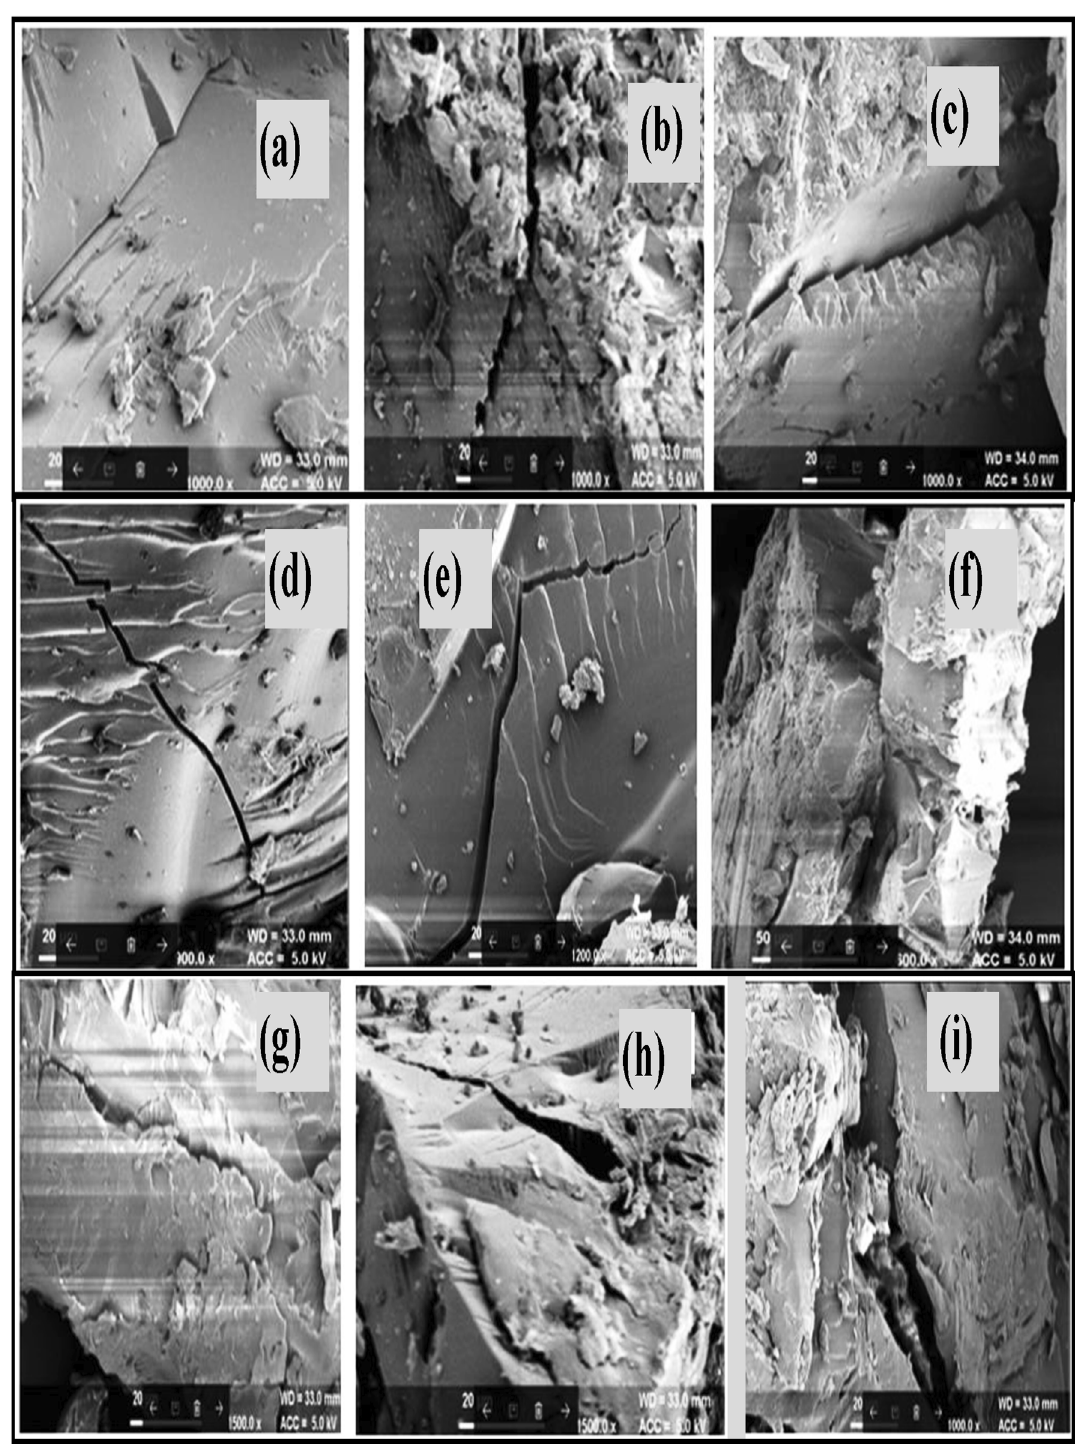
Fig. 8 a–i SEMs of biodegradation of a Av-cl-poly(AA) stage-I; b Av-cl-poly(AA) stage-II and c Av-cl-poly(AA) stage-III using soil burial method; d Av-cl-poly(AA) stage-I; e Av-cl-poly(AA) stage–II and f Av-cl-poly(AA) stage-III using composting method; g Av-cl-poly(AA) stage-I; h Av-cl-poly(AA) stage–II; and i Av-cl-poly(AA) stage-III using vermicomposting